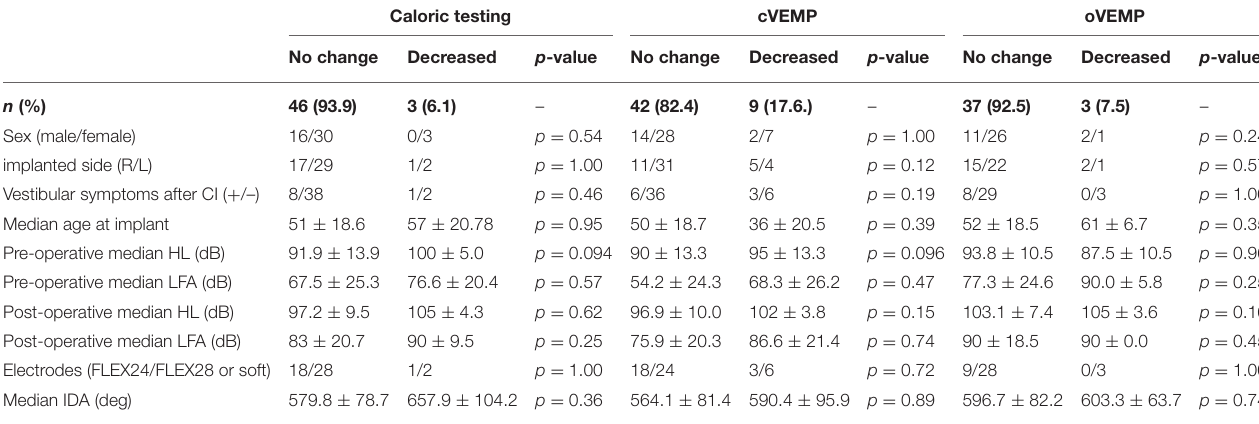
TABLE 2 | The results of vestibular changes after CI